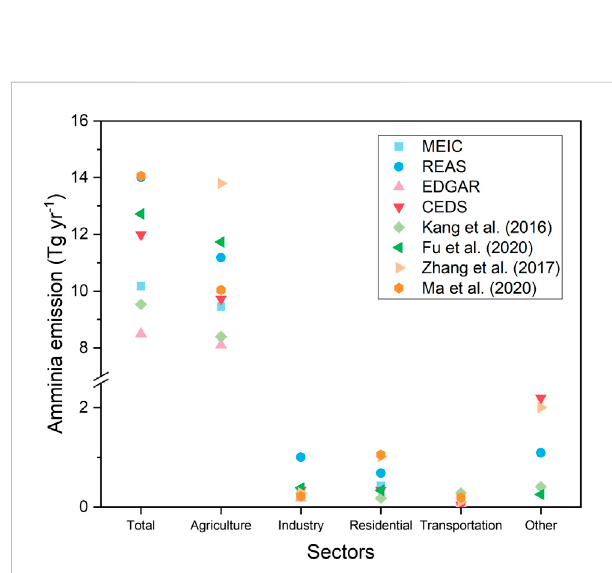
The range of differences in ammonia emission from different sectors in 2012 from eight different